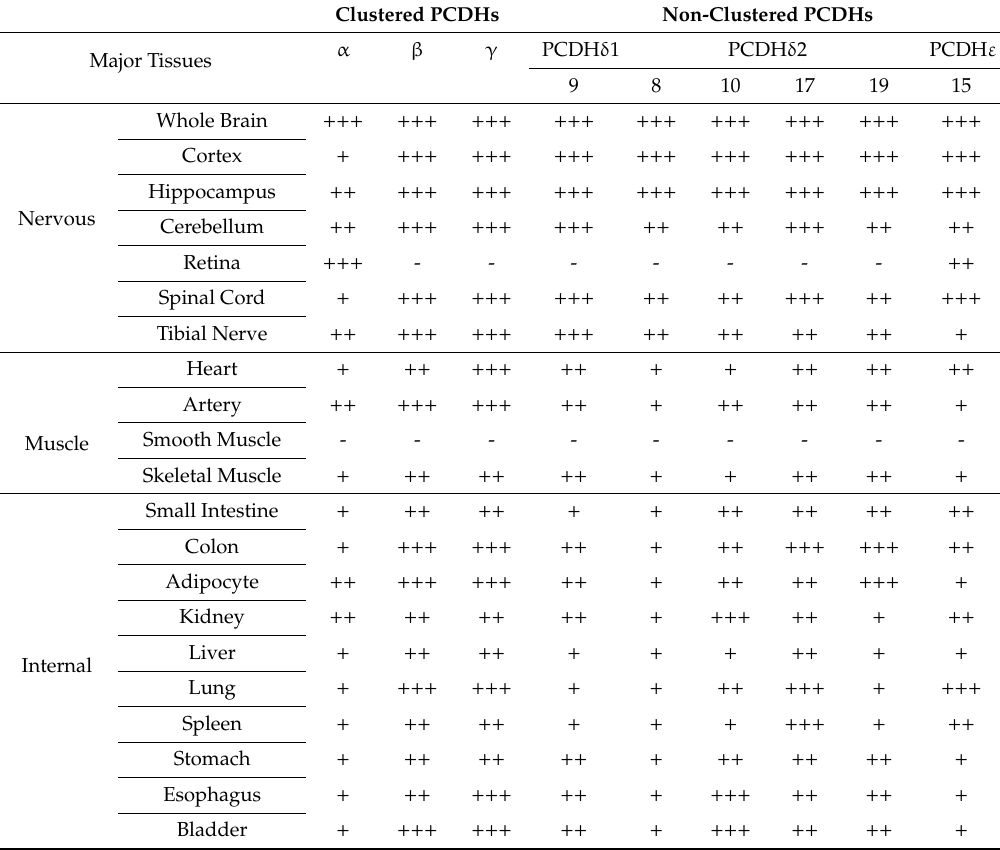
Table 1. Summary of PCDH mRNA expression in human tissues. Shown are the major PCDHs implicated in neurodevelopmental disorders. Level of expression is indicated: +++ strong; ++ moderate; + weak; -